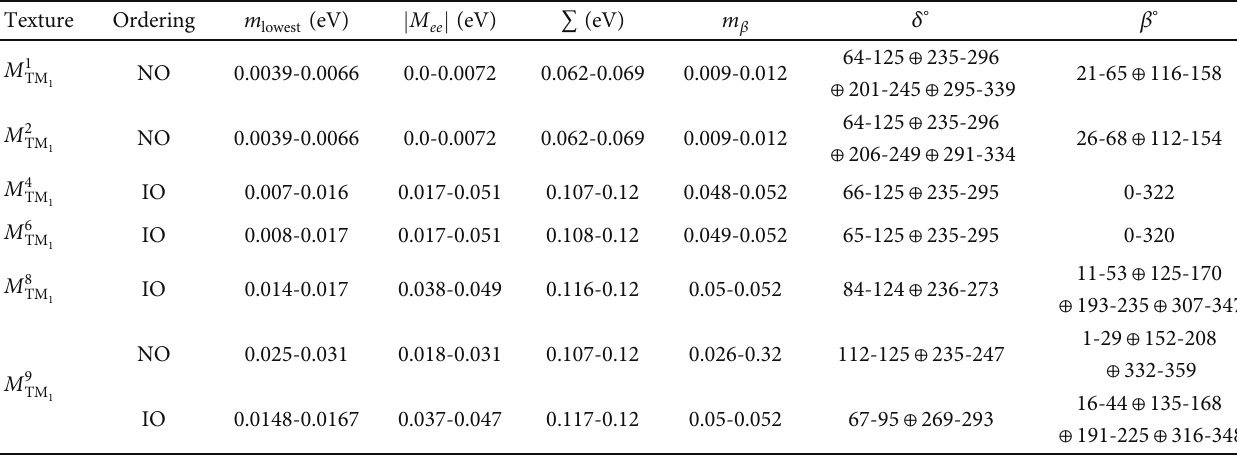
Table 6: Numerical predictions for viable textures having one equality in M double beta decay bounds along with neutrino oscillation data are